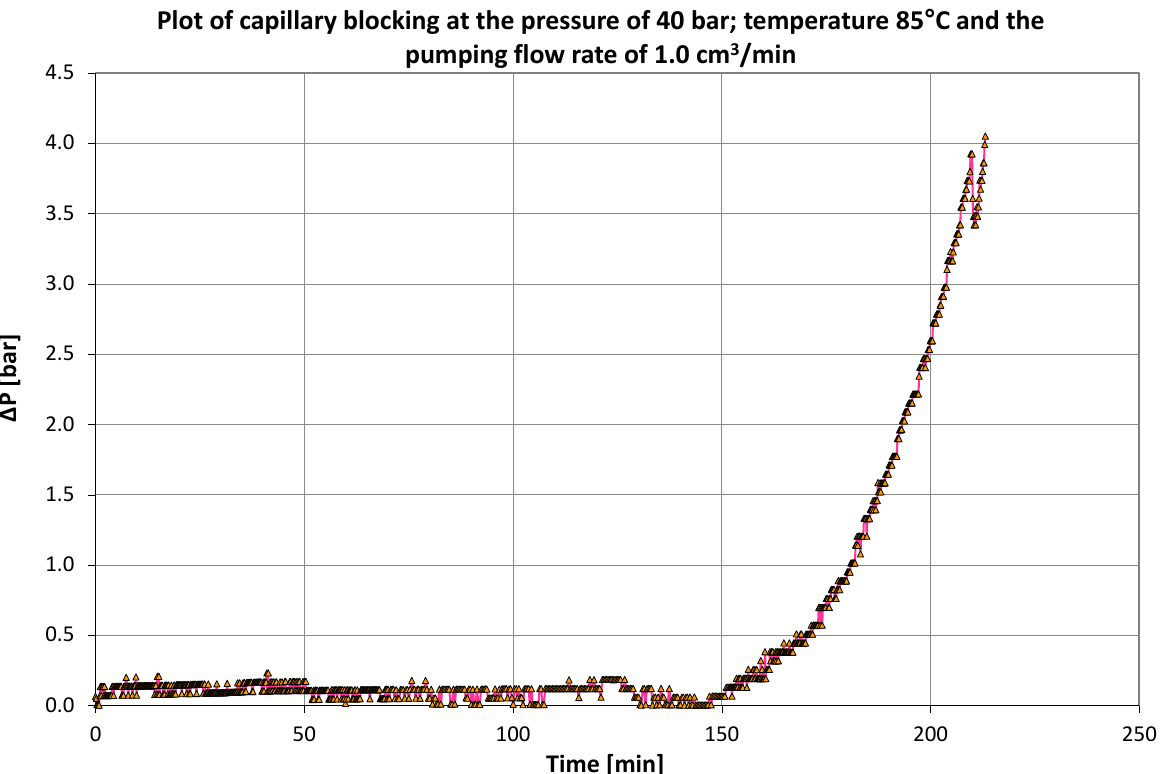
Figure 6. Tests for the precipitation of sediments for water “A” modified with sodium bicarbonate (1 g/800 mL) and water “B” at a temperature of 85 °C (measurement error is ±4%).